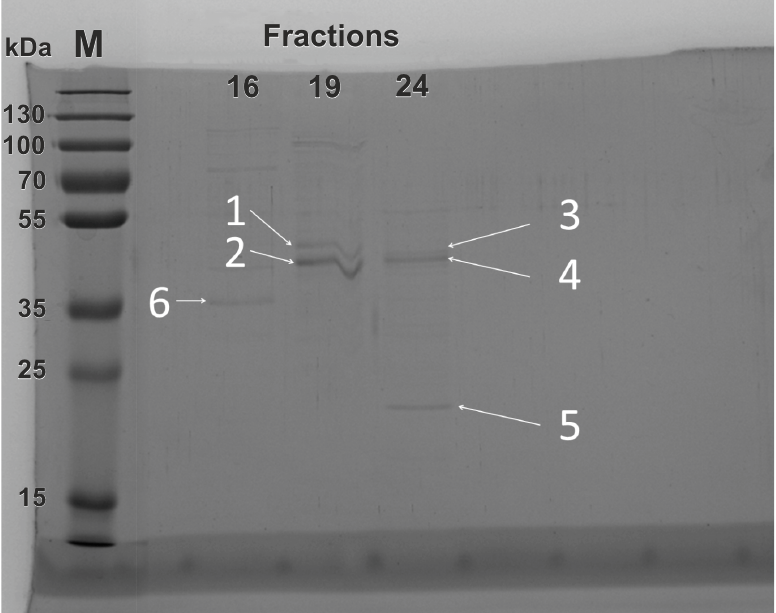
Figure 6. SDS-PAGE of fractions 16, 19, and 24. The first lane is the molecular weight marker M and white numbers 1–6 denote the bands that were analysed by MS.